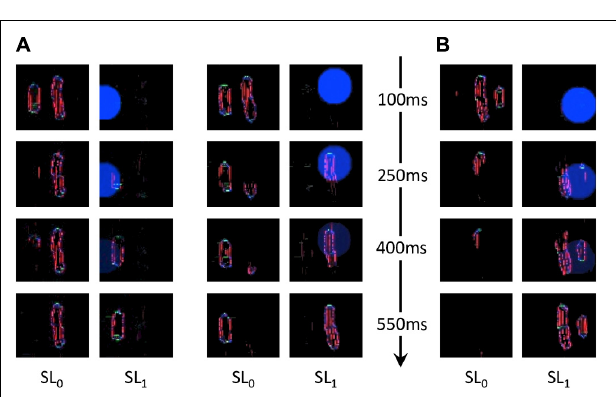
FIGURE 11 | Characteristic examples of segmentation processes for both conditions of experiment 1b of Manassi et al. (2012). Every row corresponds to the segmentation model’s output at a certain time after stimulus onset, indicated by the arrowed axis. Each pair of columns corresponds to the output of a simulation, and the content of each segmentation layer is indicated by SL 0 and SL 1 (as in Figure 4A ). (A) Two examples of successful segmentation trials for the inner flanker condition. (B) Example of a failed segmentation trial for the outer flanker condition. The probability of successfully segmenting the flanker from the target is higher in the outer flanker condition than in the inner flanker condition. The inner flanker is better represented by the retina output than the outer one, because it is presented closer to the fovea. The inner flanker appears bigger and further from the target. The resulting threshold elevation for the inner flanker condition is thus lower than for the outer flanker, corroborating the inward-outward anisotropy measured in experiment 1b of Manassi et al. (2012). Both conditions often lead to unsuccessful segmentation because the flankers are quite close to the target, given the eccentricity of the stimulus, and because the saliency model’s output computes the whole stimulus as only one object (see Figure 9 ). Thresholds for both flanked conditions are hence substantially larger than for the unflanked